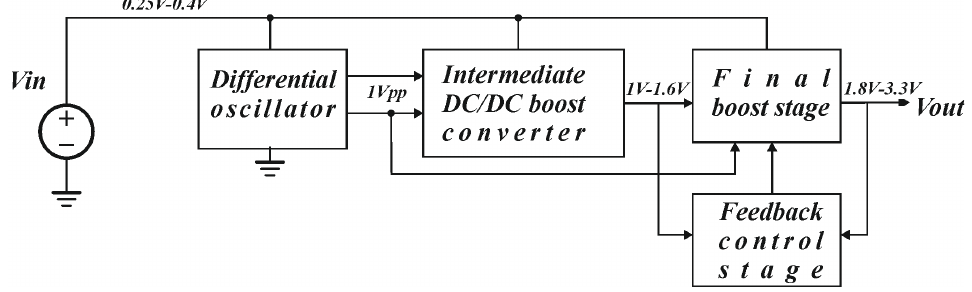
Figure 7. The inductive converter presented in